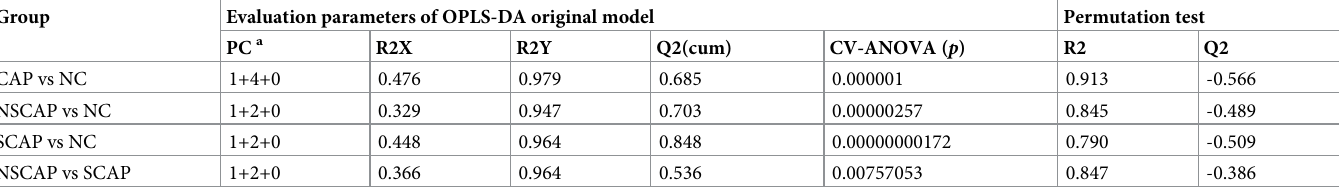
Table 2. Evaluation parameters of our OPLS-DA